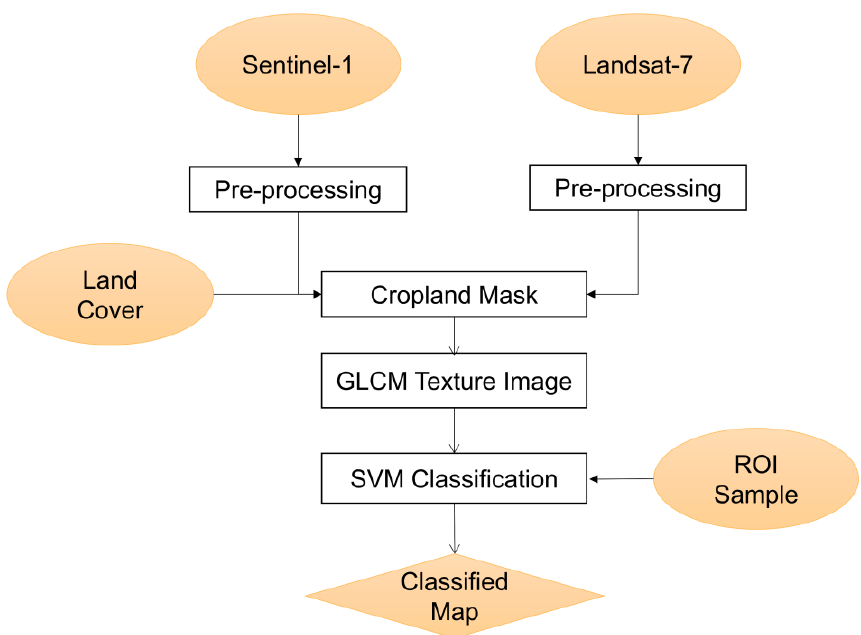
Figure 2. Flowchart of crop classification based on the GLCM mean texture features.